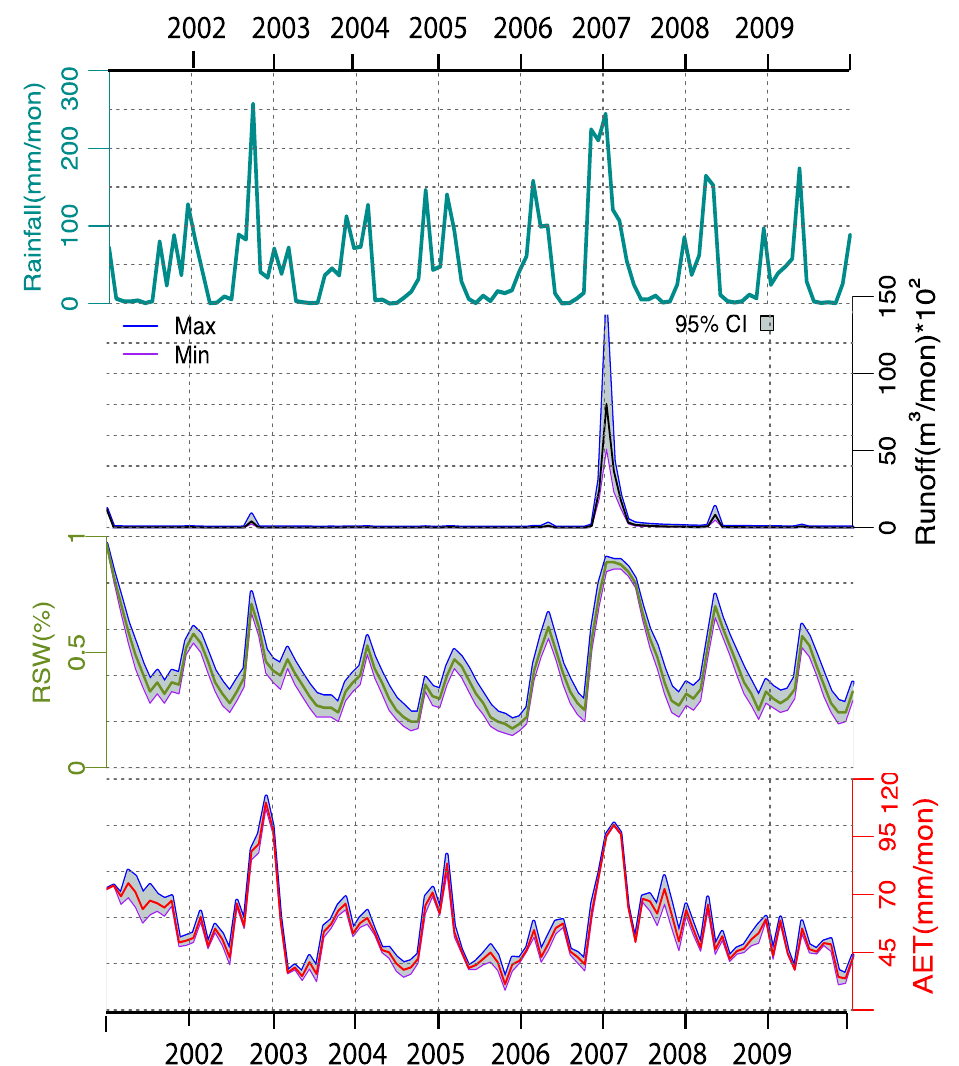
Figure 9. Monthly variation of the components of water balance in Lake Manyara basin during the study period. RSW = Relative soil water, Max and Min stands for maximum and minimum predicted values and CI = confidence